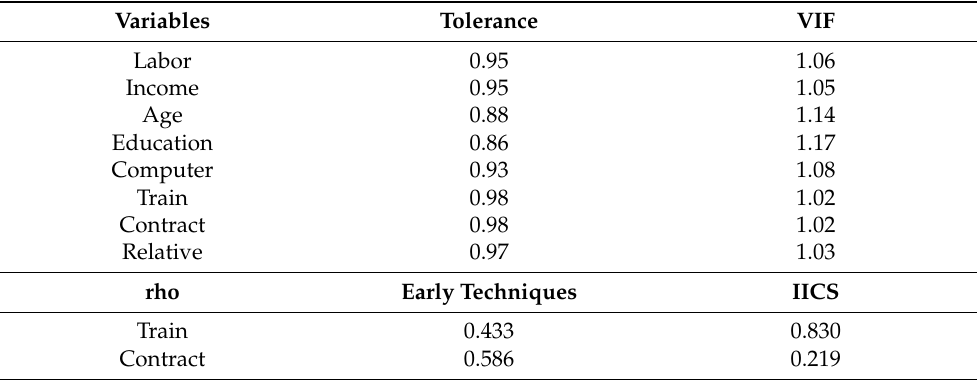
Table 2. Results of the Collinearity Diagnostics and Heckman